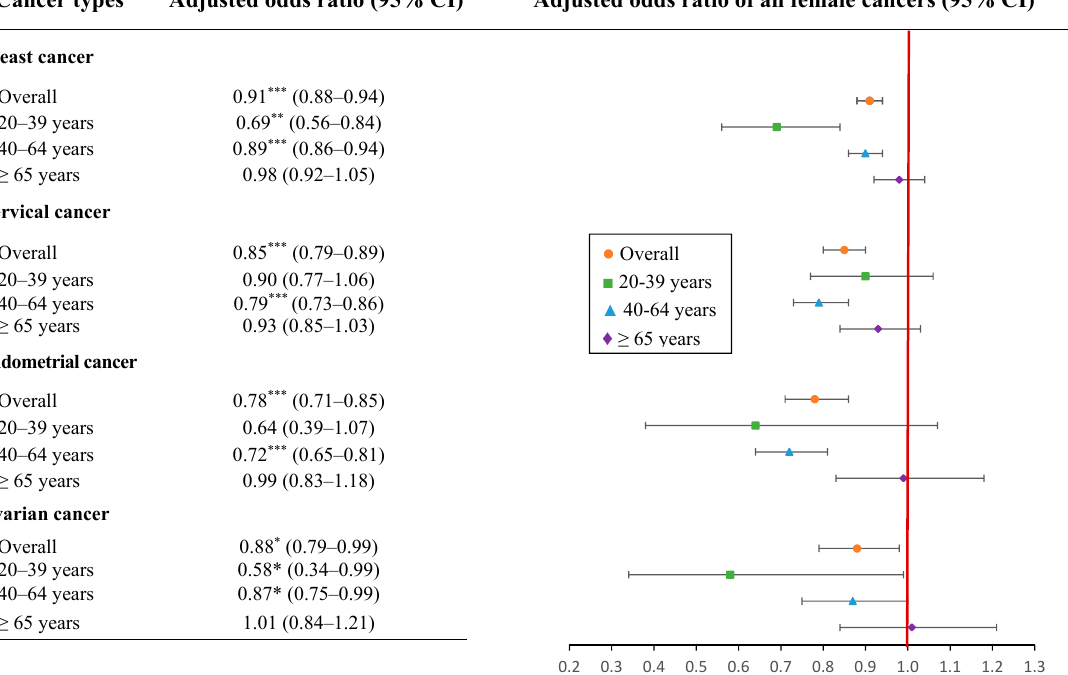
Figure 3. The association of PPI use with breast, cervical, endometrial, and ovarian cancer risks by age groups with adjusted odds ratios. CI, confidence interval. Footnote: * p < 0.05, ** p < 0.001, *** p <